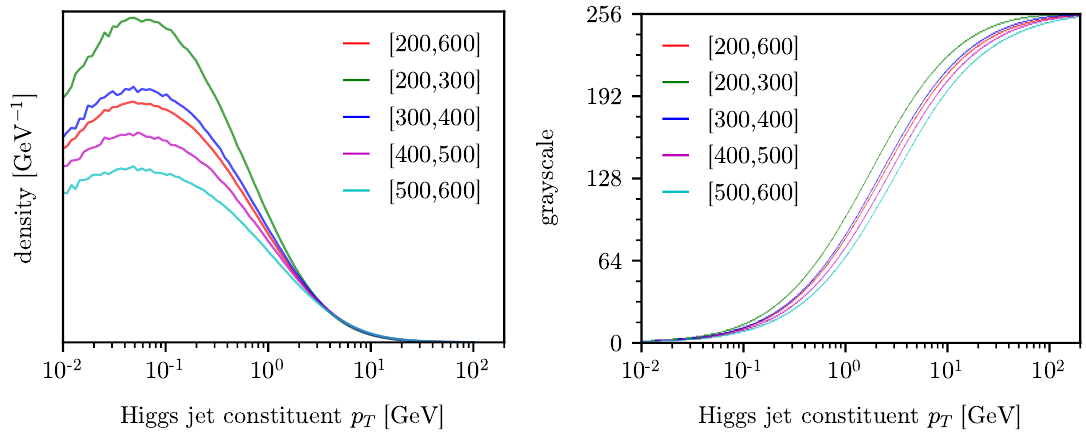
Figure 1. Left panel: transverse momentum distributions of Higgs decay products for training samples in different p H ranges (in unit of GeV). Right panel: pixel intensity normalization schemes T for different p H T